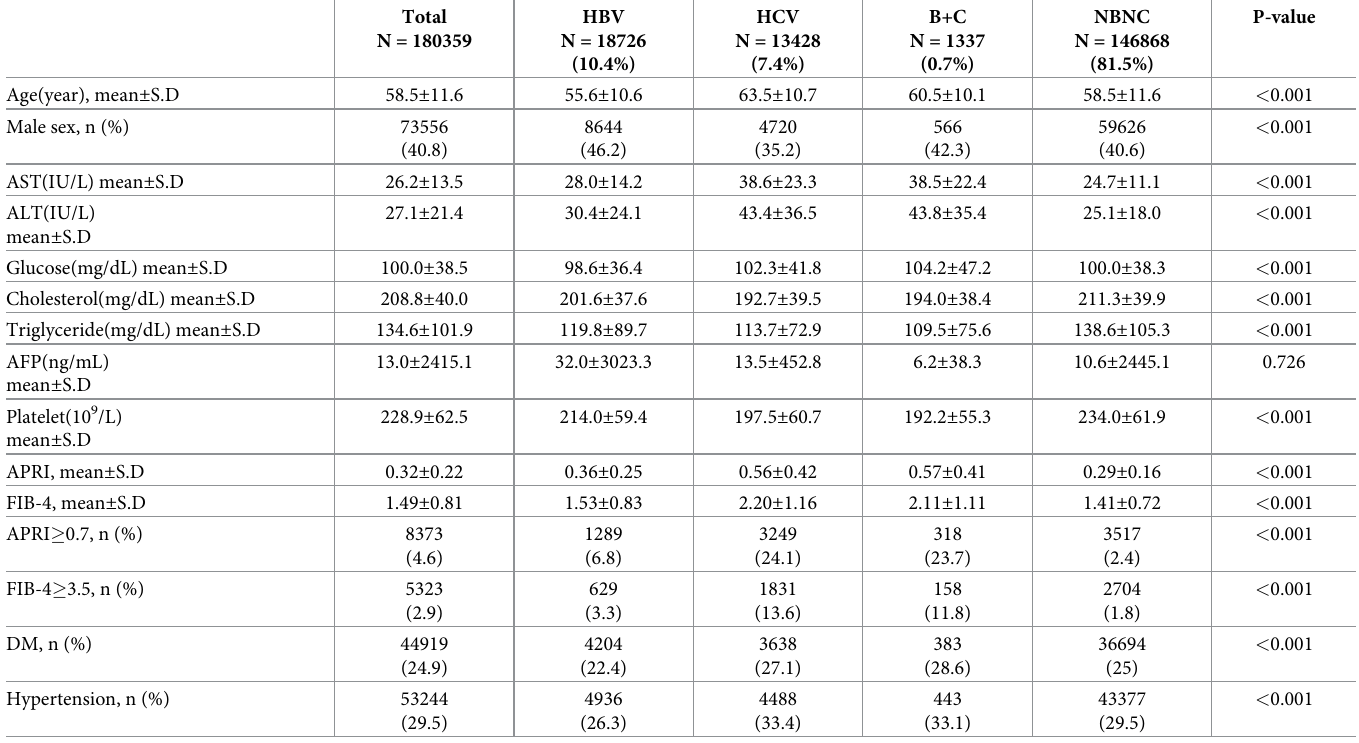
Table 1. Clinical characteristics of enrolled 180359